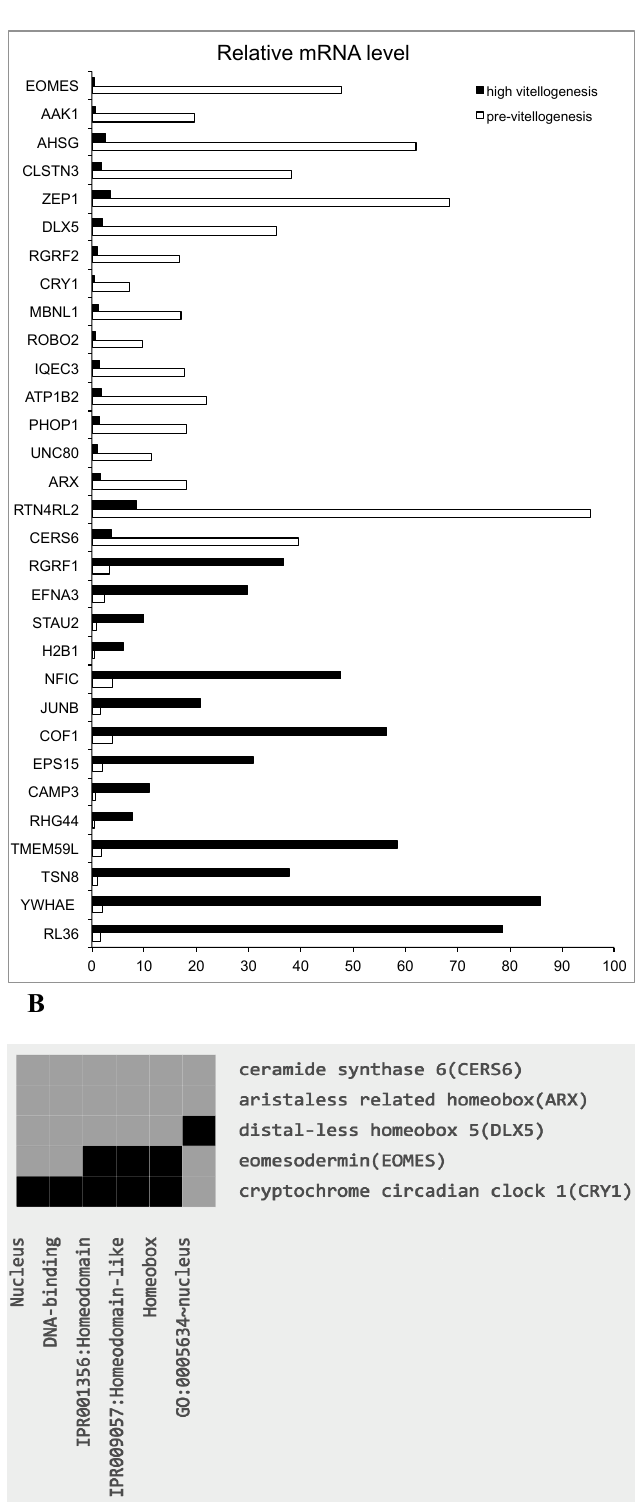
Figure 2. ( A ). Relative mRNA levels (based on RNA-Seq) of transcripts associated with known genes and showing significant di ff erences in edgeR analysis ( P < 0.001) between adult and juvenile blue gourami female brains. ( B ): Gene-annotation association of a cluster of genes encoding nuclear proteins, all upregulated in PVTL. Analysis was performed using DAVID software with default parameters. Grey tint of squares denotes a positively reported corresponding gene-term